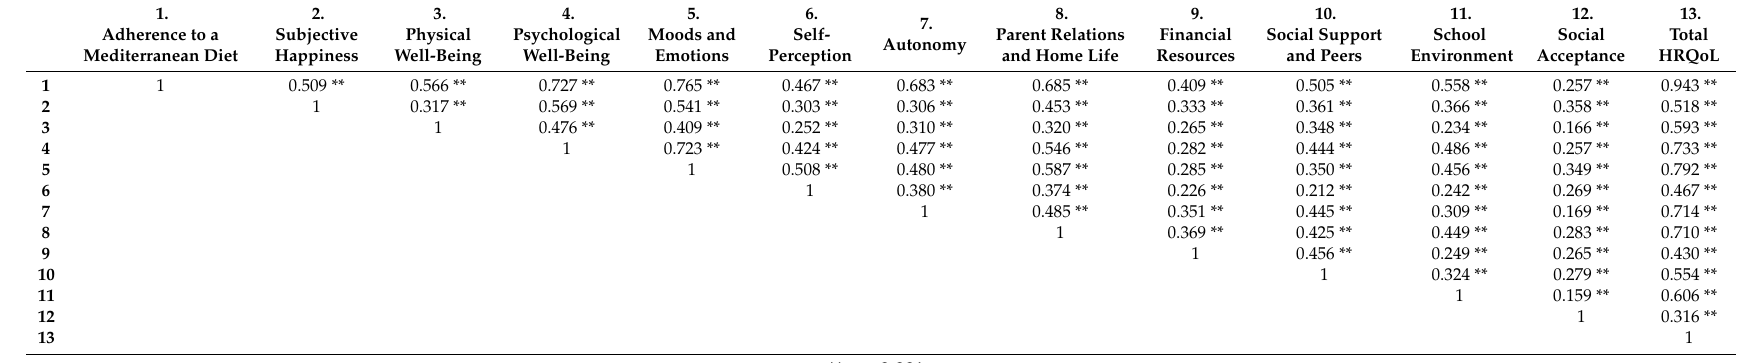
Table 1. Patterns of correlations between adherence to a Mediterranean diet, happiness and health-related quality of life dimensions.